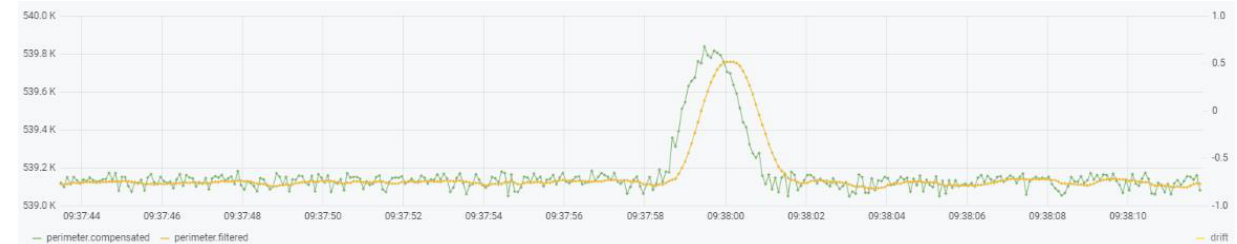
Figure 8. EWMA filter performance.